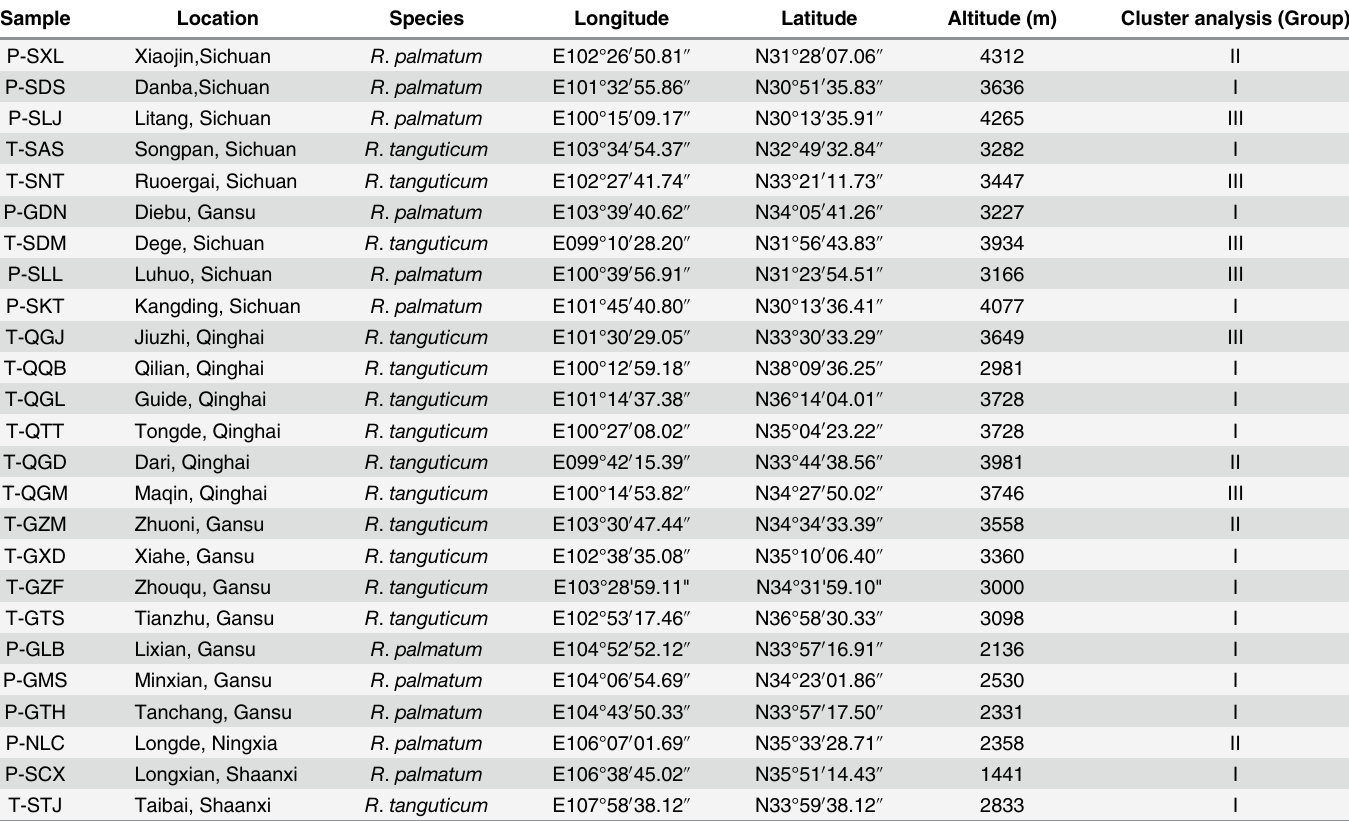
Table 2. Locations, species, altitude, latitude and longitude of